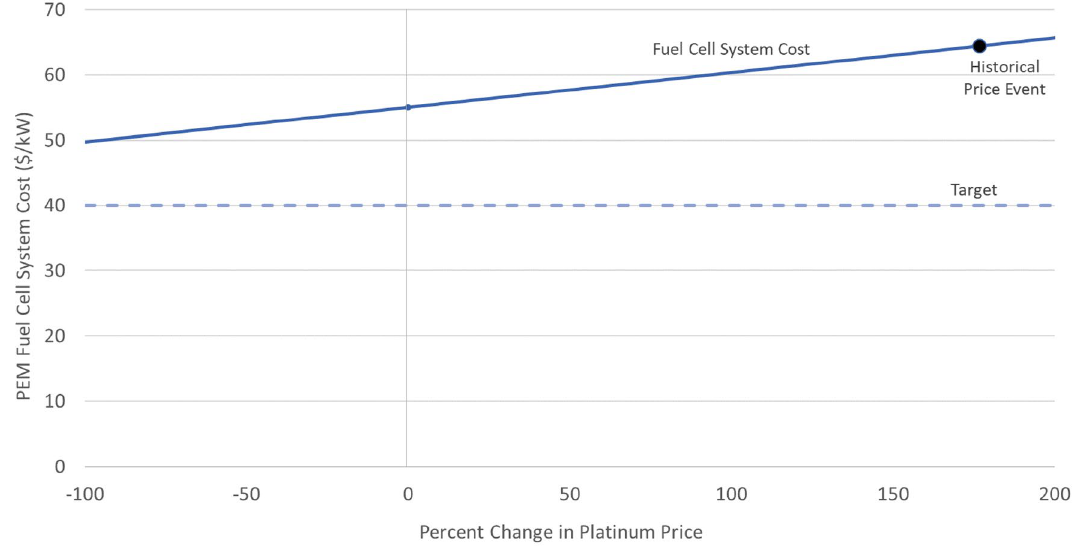
Fig. 3 Impact of platinum price changes on the overall PEM fuel cell system cost. The black dot is representative of the fuel cell costs that could occur under a scenario of current platinum intensities experiencing the platinum price spike that occurred in 2008. Sources: [52,